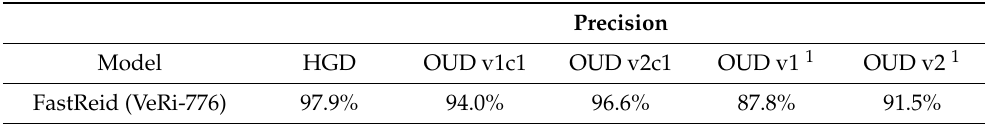
Table 5. Accuracy in positive–negative pair test in HGD and OUD datasets for vehicle re- identification.